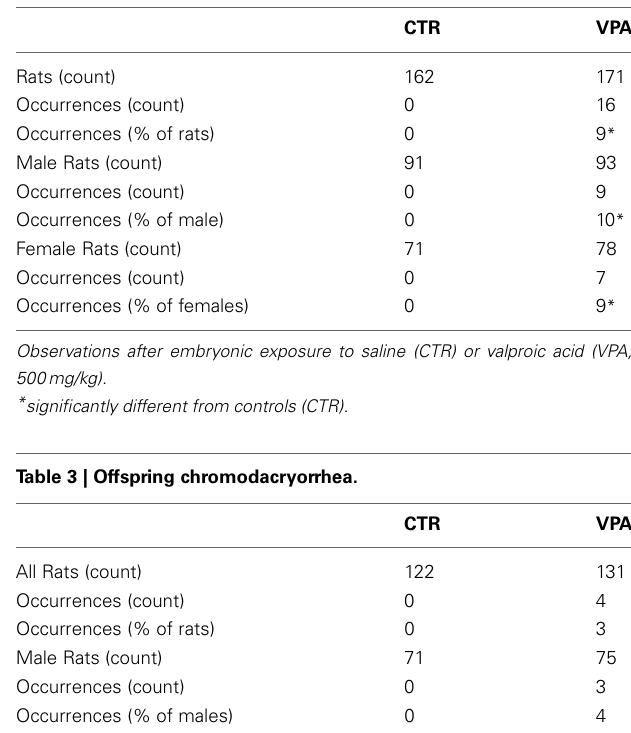
Table 2 | Offspring tail malformations.